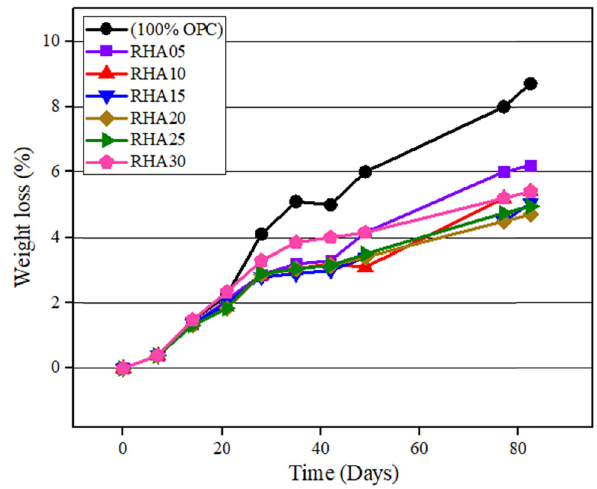
Figure 12: Weight losses in 5% HCl [ 34 ]